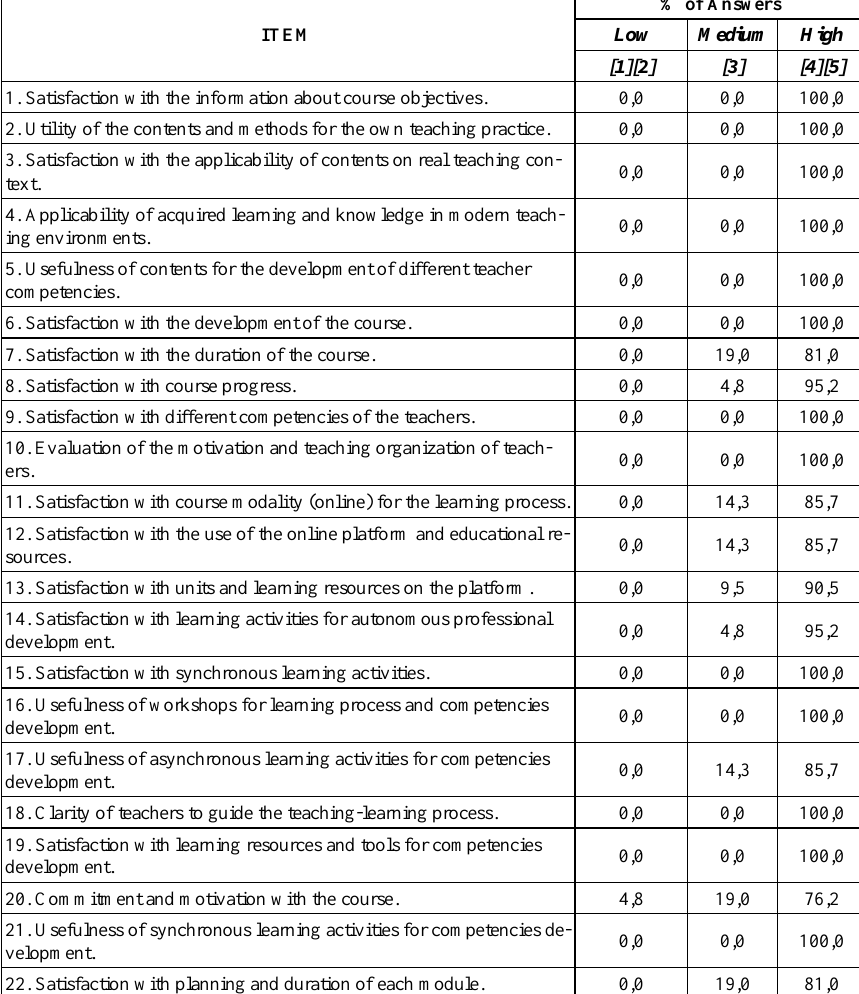
Table 4. Results of the closed